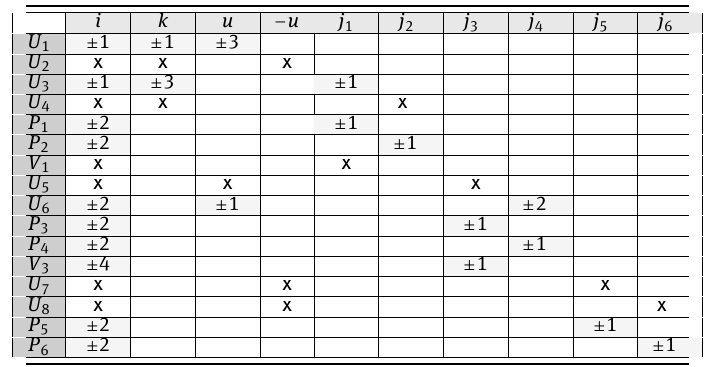
Table 13. Index distribution on B i ∪ C i ∪ D i ∪ E i and on 6 words of type [± 2, ± 1 ]